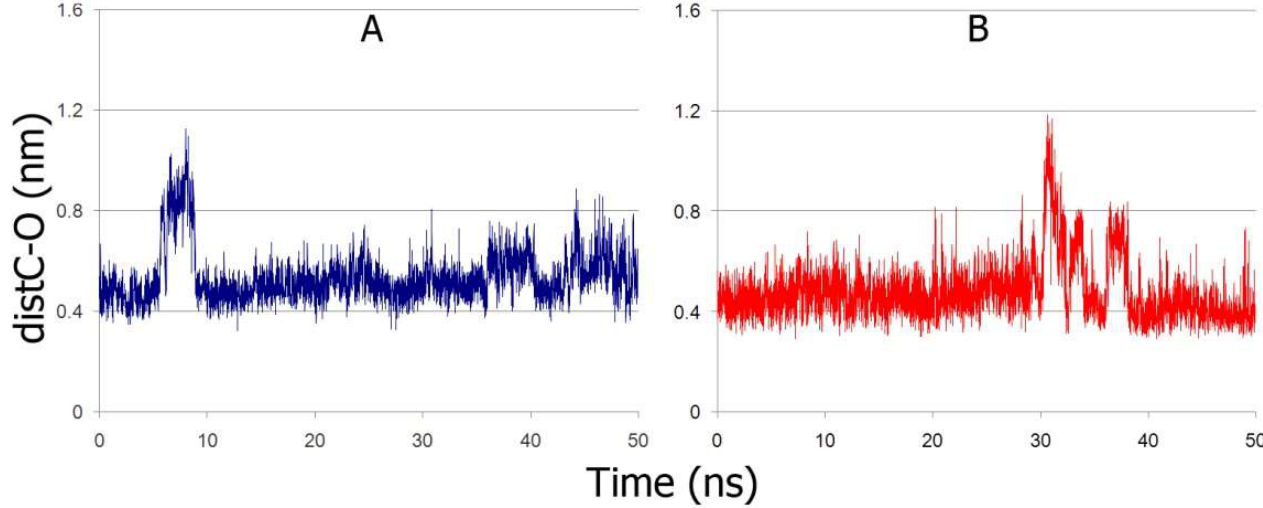
Figure 7. Time change of the distance (distC-O) between the carbonyl carbon of NPA and the hydroxyl oxygen atom of catalytic tyrosines of BSA according to MD simulation. ( A ) Sudlow site I with catalytic tyrosine Tyr149, ( B ) Sudlow site II with catalytic Tyr410.